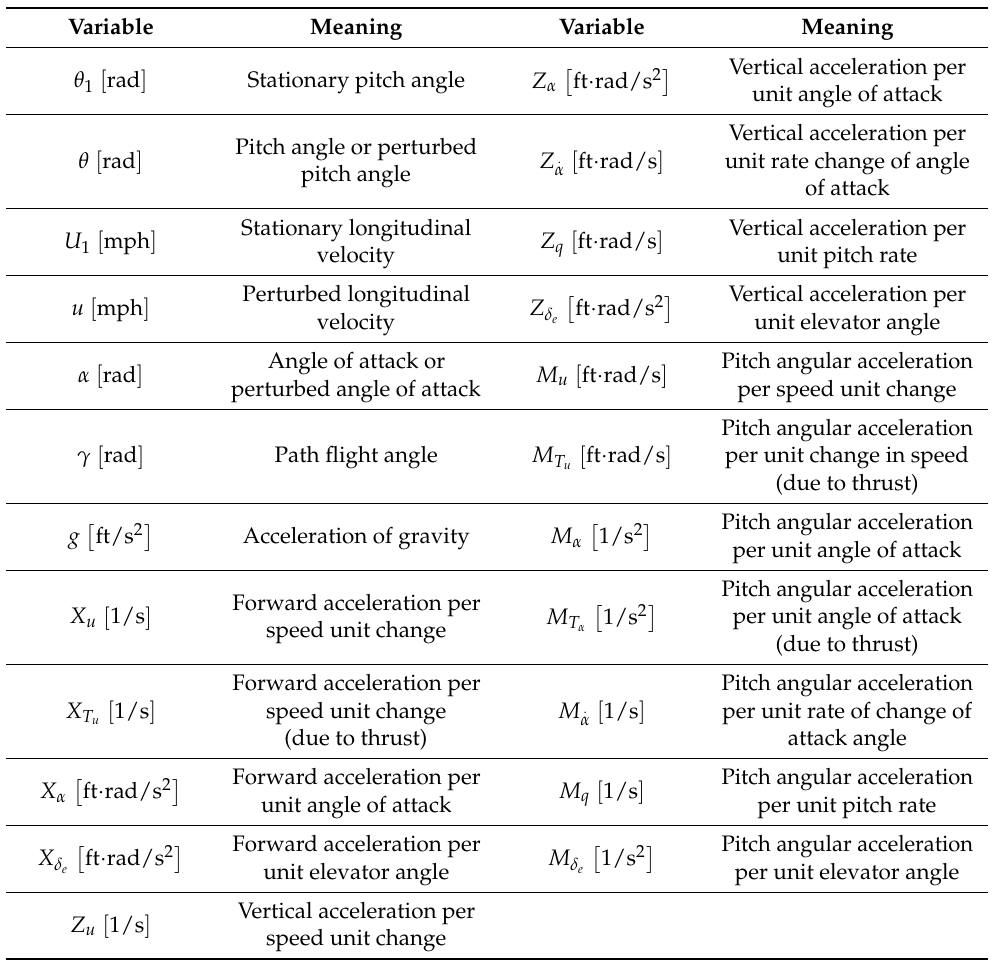
Table 1. Glossary of terms used in the control of the